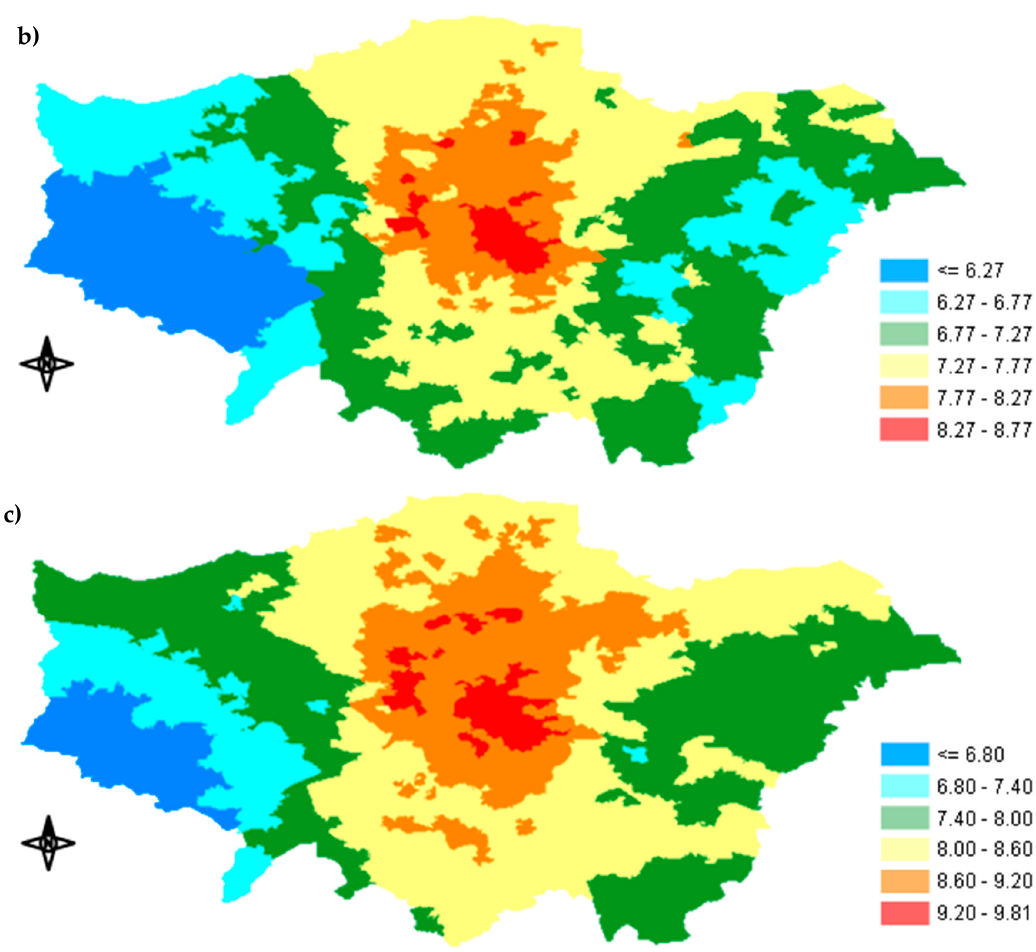
Figure A1. Map of GLA showing the spatial distribution of the annual mean exposure concentration ( μ g/m 3 ): ( a ) Tier 2, ( b ) Tier 3 and ( c ) Tier 4.